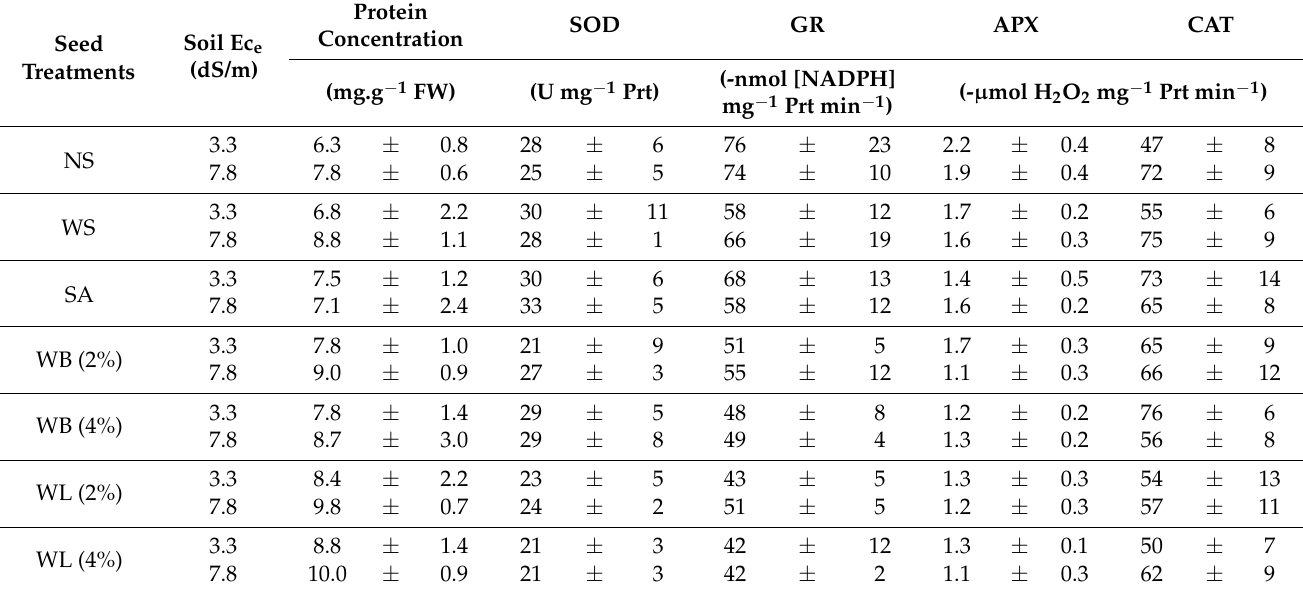
Table 6. Changes in protein concentrations and specific activity of antioxidative enzymes (SOD, GR, APX, CAT) of 2- week-old soil-grown maize ( Zea mays cv. Caramelo) shoots in response to salinity (non-saline, EC e = 3.3 dS/m; saline, EC e = 7.8 dS/m) and different seed treatments (NS, non-soaked; WS, water-soaked; SA, salicylic acid (0.5 mM); WB, willow bark extract (2% or 4% w / v ); WL, willow leaf extract (2% or 4% w / v